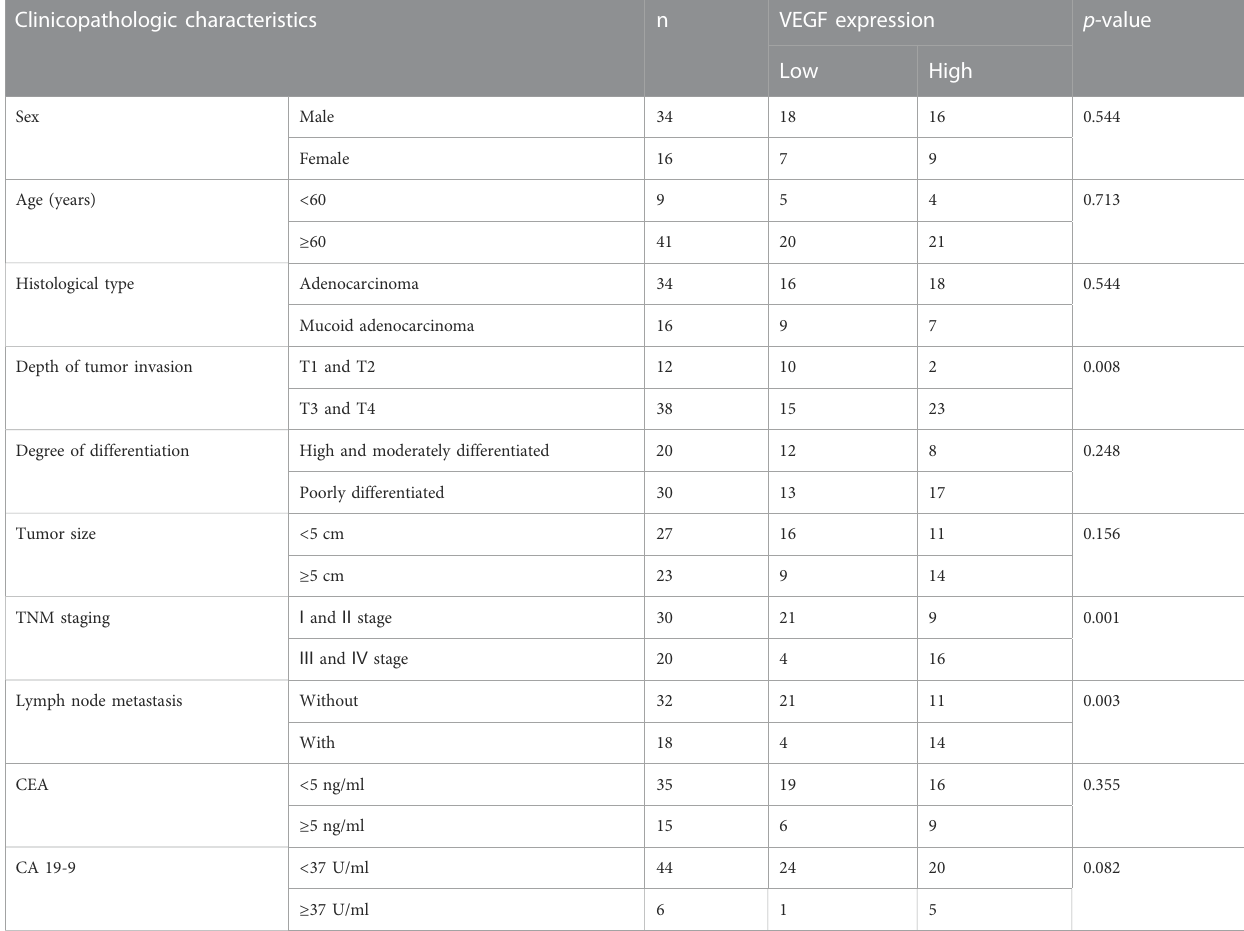
TABLE 2 Correlation between VEGF and clinicopathologic